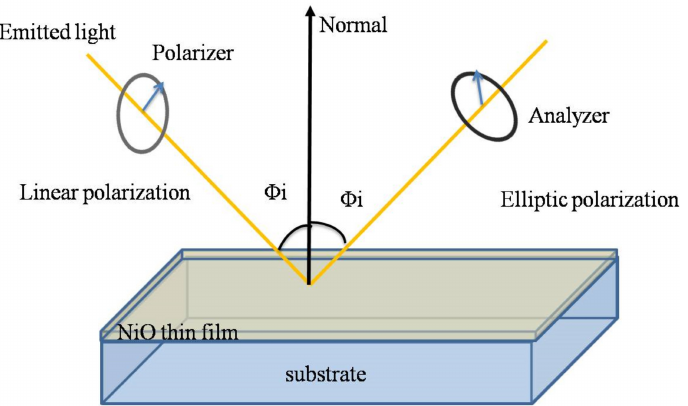
Figure 5. General geometry light path in an